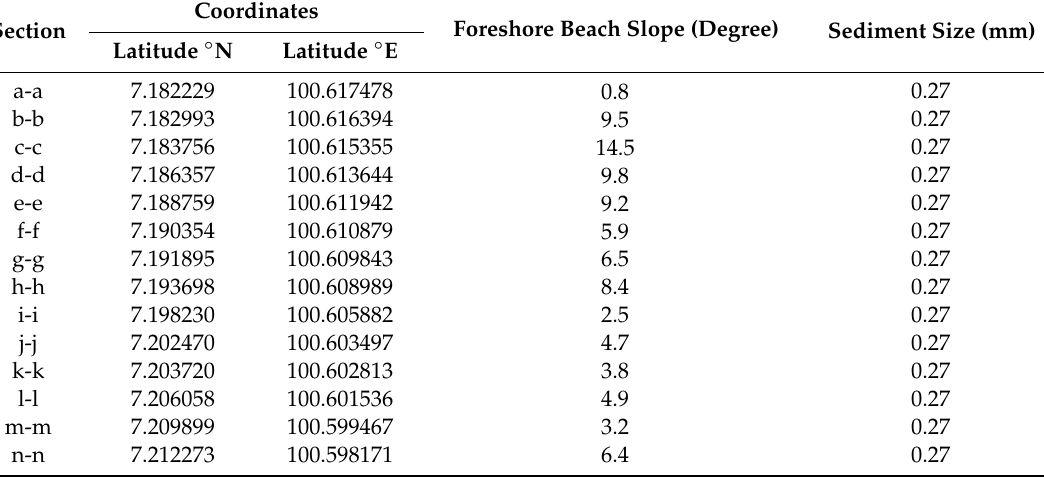
Figure 3. Survey sections of Chalatat beach. Table 3. Slope, sediment size of Chalatat beach.